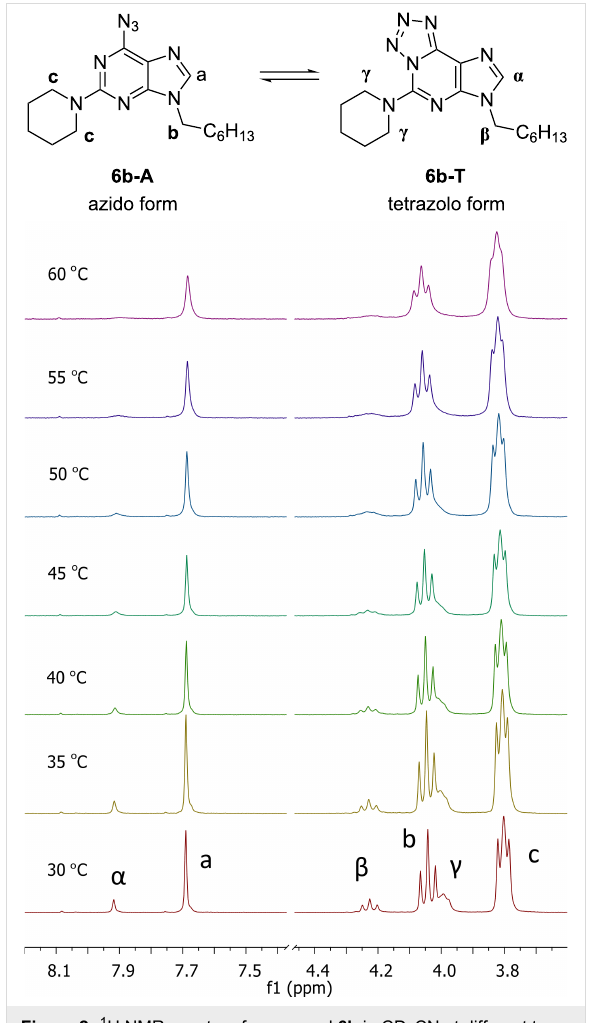
Figure 2: 1 H NMR spectra of compound 6b in CD 3 CN at different tem- peratures (300 MHz, c = 12.5 mg/mL); a, b, c – signals for azide form 6b-A ; α , β , γ – signals for tetrazole form 6b-T